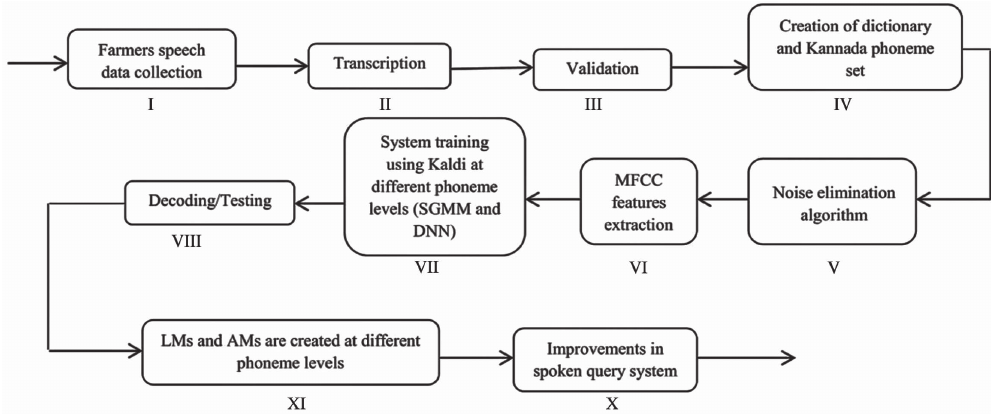
Figure 1: Block Diagram of Different Steps Involved in the Development of Kannada Spoken Query